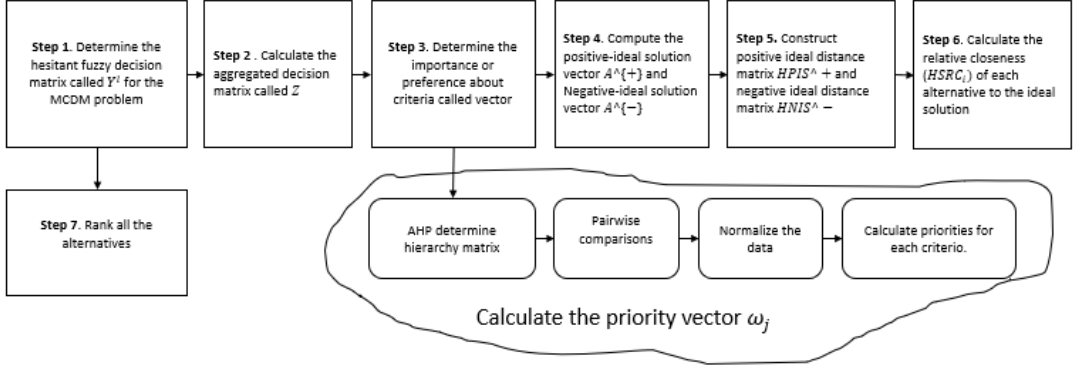
Figure 1. Flowcharts of the algorithms to assess the Lean Manufacturing